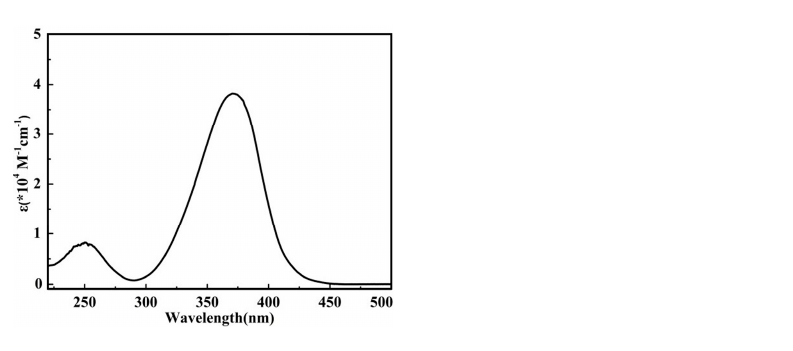
Figure 1. Chemical structures of BFC and different additives.